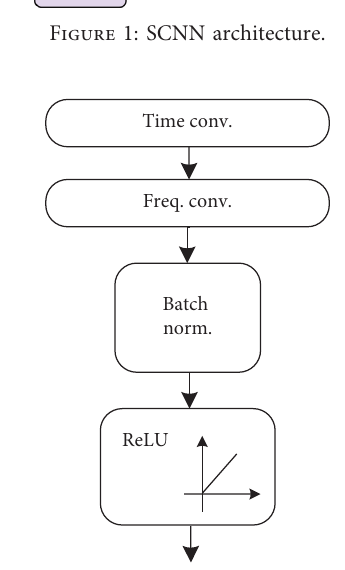
Figure 2: SC hidden layer